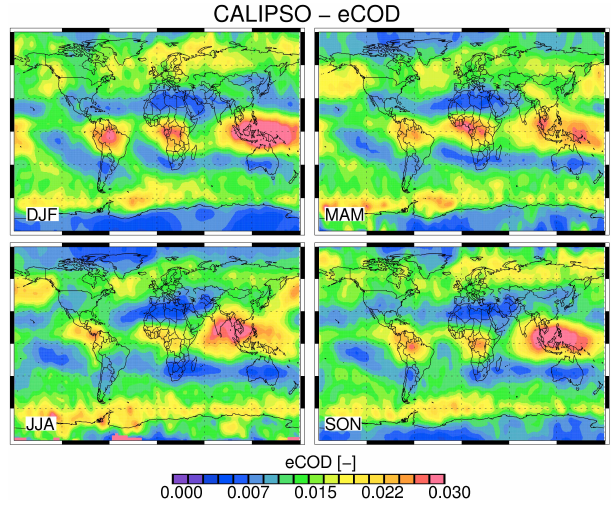
Fig. 5. Seasonal averages of effective cloud optical depth (eCOD) obtained from 2007/2008 CALIPSO/CALIOP data for clouds with COD less than 0.1.